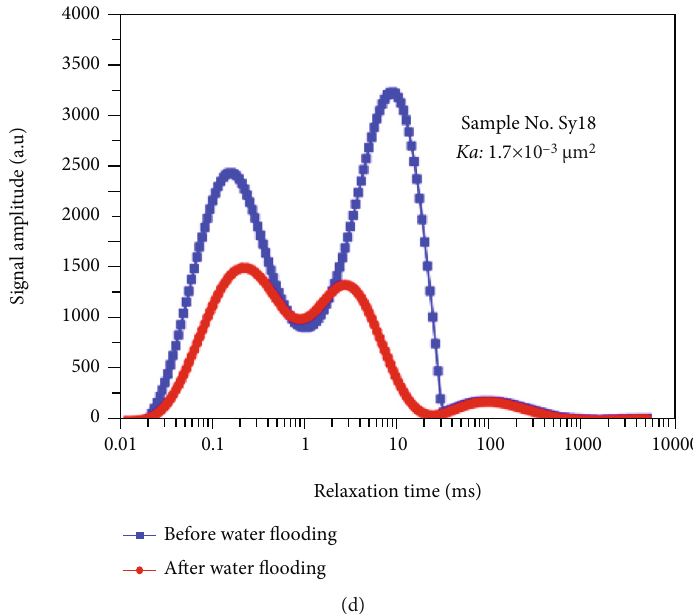
spectrum before water fl ooding, and the blue line 2